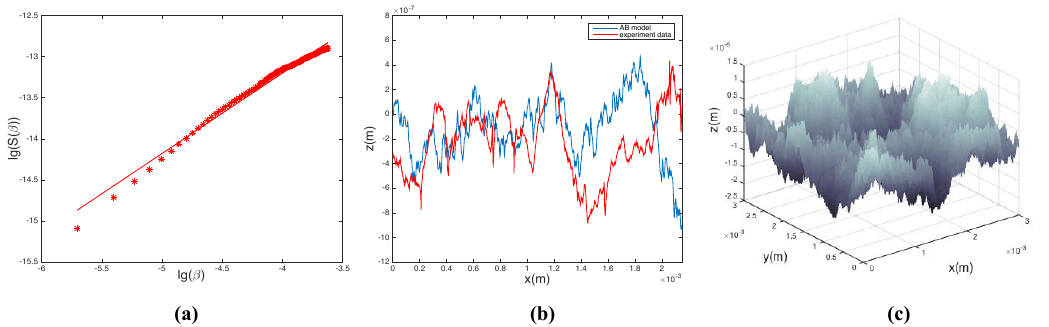
Figure 5. Fractal theory characterization of the sample sealing surface. ( a ) The logarithmic relationship between the structure function S ( β ) and the scale β obtained from one set of sample cross-sectional profile data. ( b ) The cross-sectional profile of sealing surface, and the blue line and the red line denote the fitted profile (AB model) and the measured profile (experiment data), respectively. ( c ) The fitted three-dimensional sealing